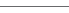
followed by a 5-min break and then their first training session ( ∼ 20 min). In sessions 2–15, participants underwent ∼ 20 min of training per session. Participation concluded with session 16